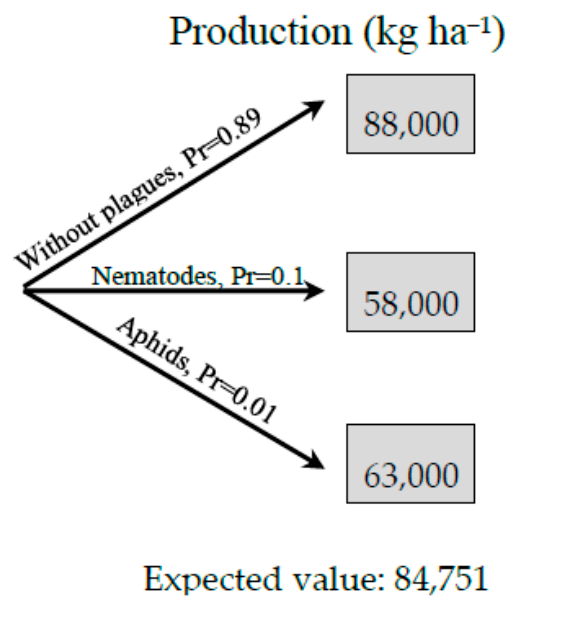
Figure 4. Decision tree of loss due to nematodes and aphids.